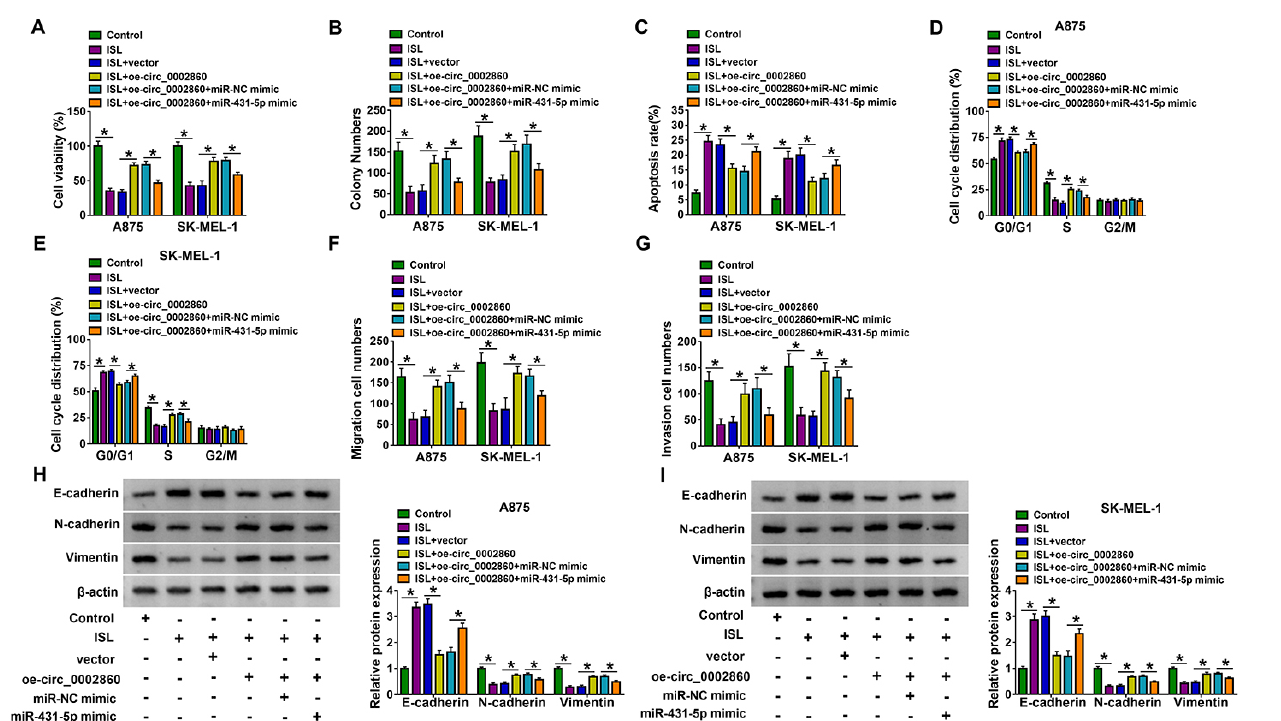
Figure 4. ISL inhibited the melanoma progression by targeting the circ_0002860/miR-431-5p axis. A875 and SK-MEL-1 cells were treated with control, ISL (60 µg/mL), ISL+vector, ISL+oe-circ_0002860, ISL+oe-circ_0002860+miR-NC mimic, ISL+oe-circ_0002860+miR-431-5p mimic. (A) Cell viability and (B) proliferation were detected by CCK-8 assay and colony formation assay. (C) Cell apoptosis and (E, F) cell cycle were assessed by flow cytometry. (F) The migration and (G) invasion abilities were determined by transwell assay. (H, I) EMT markers were examined by western blot. * p <